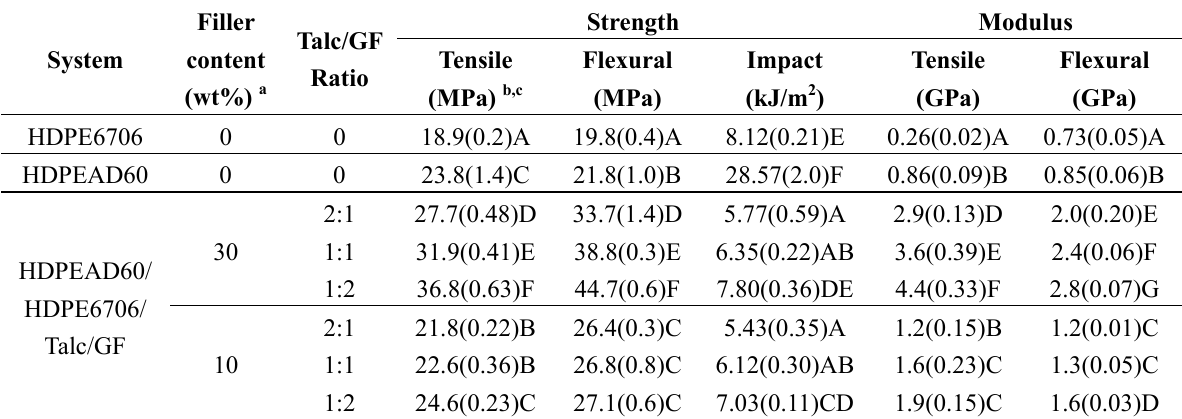
Table 3. Summary of mechanical properties of neat HDPE and filled HDPE composites with combined fillers.